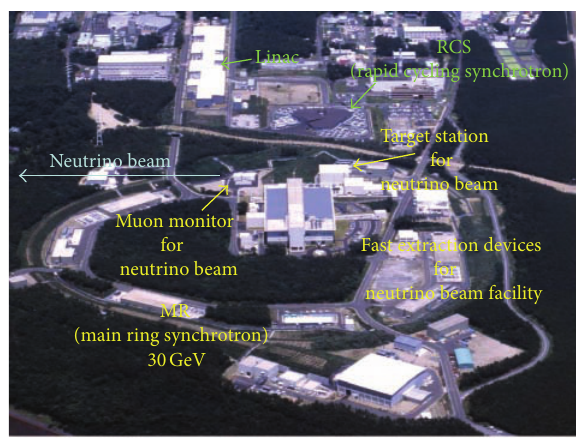
Figure 9: J-PARC accelerator and experimental facility.